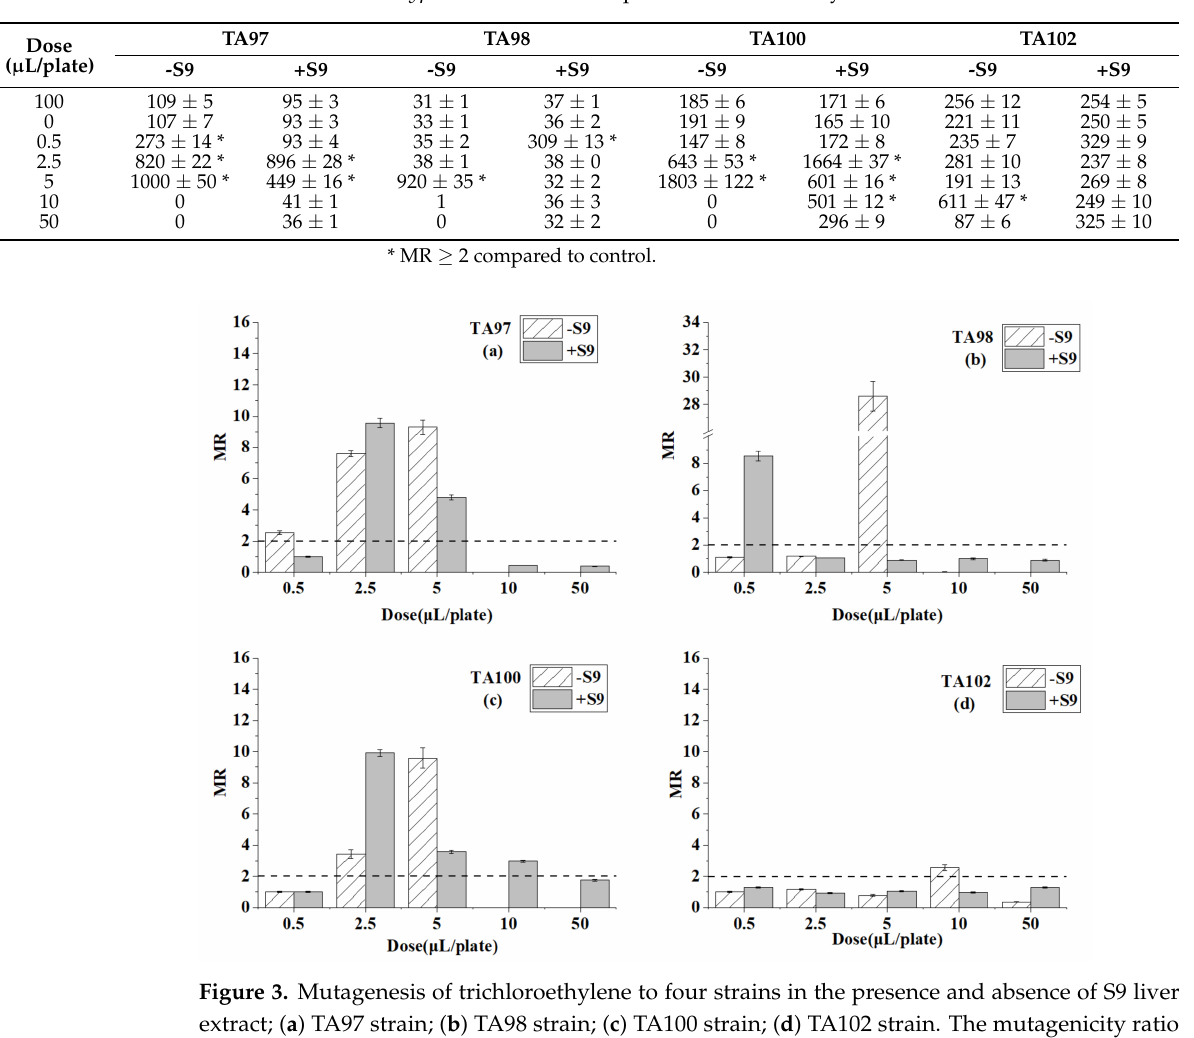
Table 3. Reverse mutation colonies of four S. typhimurium strains exposed to trichloroethylene with and without S9.